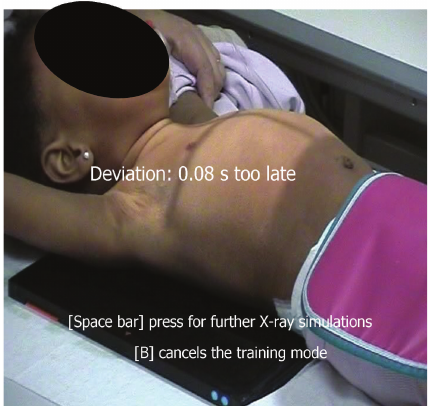
Figure 1: Frozen frame after simulation of a chest X-ray in a crying infant (17-month-old child) (training child 2) after the space bar is pressed. The center of the image shows that the running video was stopped 0.08 s too late for an X-ray at deepest